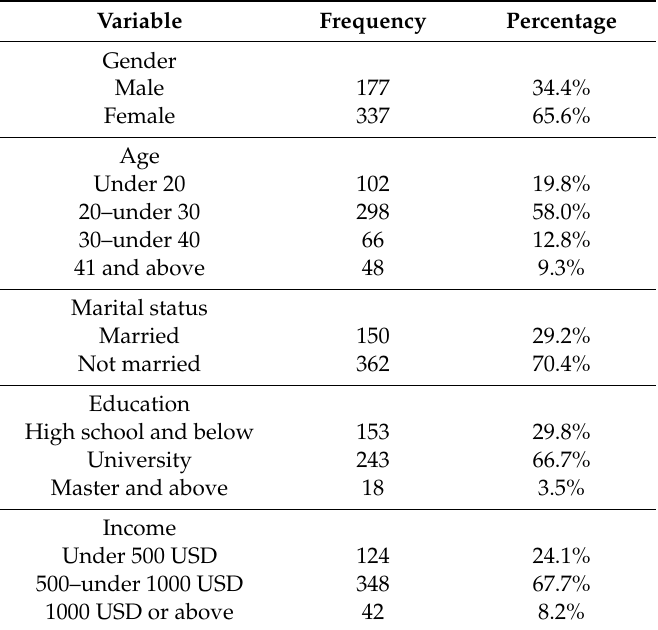
Table 2. Sample characteristics ( N = 514).